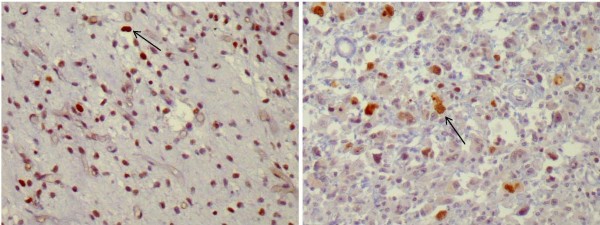
a) Area of extremity liposarcoma with moderate expression of topoisomerase IIa (21-50% of neoplastic cells showed nuclear immunoreactivity (arrow) (DAB X400). b) Weak expression of topoisomerase IIa in extremity liposarcoma (< 20% of neoplastic cells showed nuclear immunoreactivity (arrow) (DAB X400).